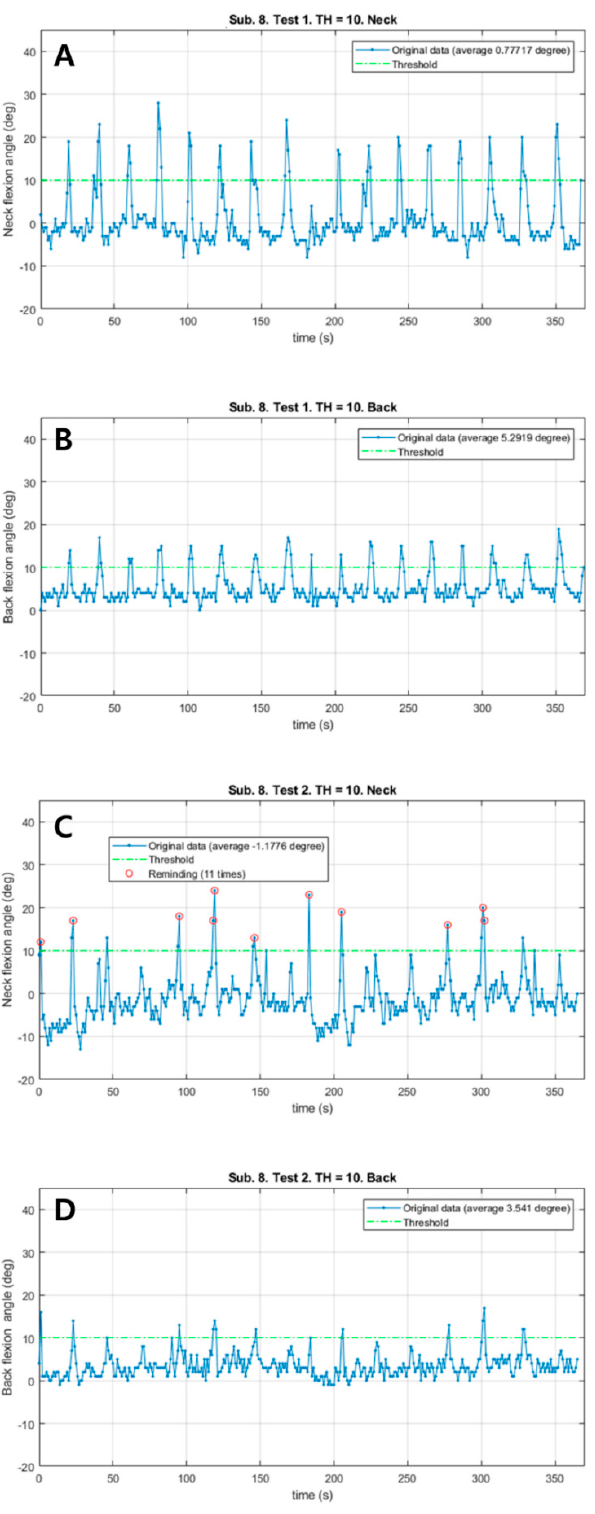
Figure 3. The changes of neck and back flexion angles continuously measured during 6 min walk test in patient #6. ( A ) The changes of neck flexion angles in the control session. ( B ) The changes of back flexion angles in the control session. ( C ) The changes of neck flexion angles in the vibration session. ( D ) The changes of back flexion angles in the vibration session. Red circles: Reminding the patient by vibration